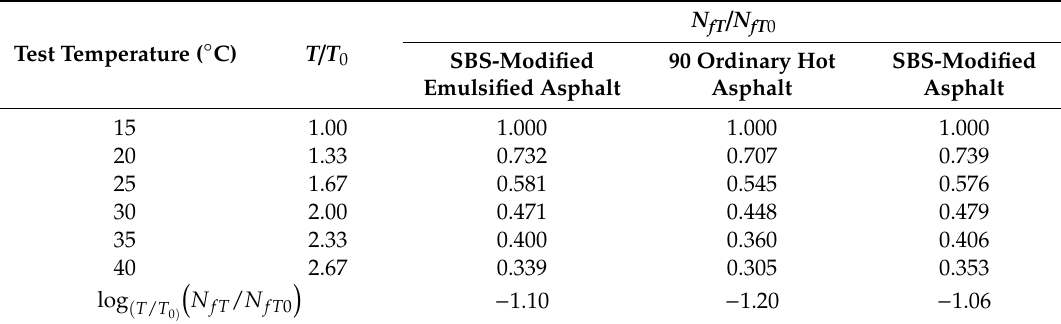
Table 10. Temperature correction coe ffi cient for the fatigue life model.